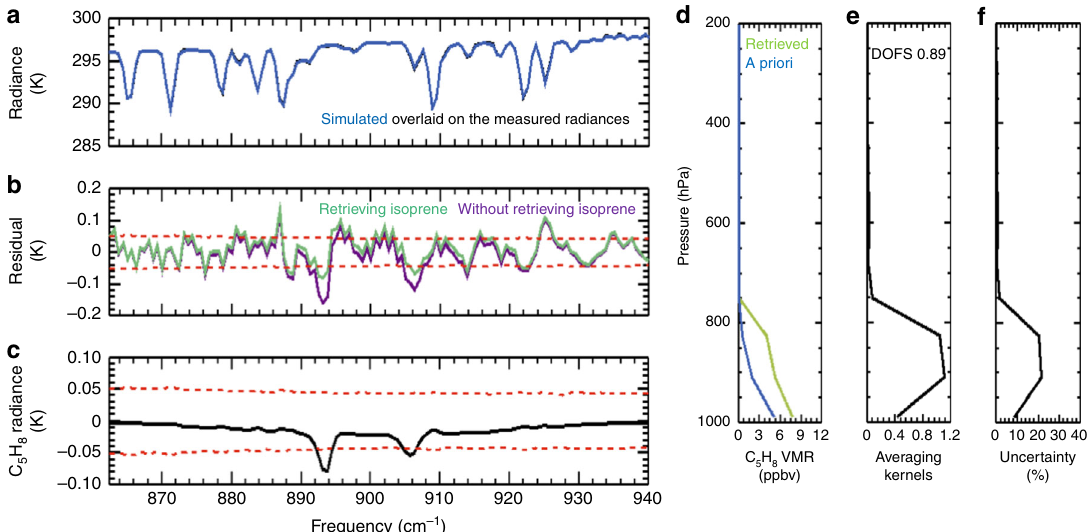
Fig. 4 An example CrIS isoprene retrieval over Amazonia (8.698°S, 69.134°W) on September 30, 2014. a Calculated (blue) spectrum overlaid on the CrIS- measured (black) spectrum, plotted in brightness temperature units. The major features are due to H 2 O vapor. b Residual spectra (observed — calculated) after accounting for water vapor (H 2 O), nitric acid (HNO 3 ), ammonia (NH 3 ), and relevant surface and cloud properties. The purple line indicates the residual spectrum before accounting for isoprene (C 5 H 8 ), clearly showing the isoprene signals peaking at 893.75 cm − 1 ( ν 28 band) and 906.25 cm − 1 ( ν 27 band). The green line depicts the residuals after fi tting for isoprene. The red dashed lines denote the single-pixel CrIS noise level as reported in the CrIS L1B data product. c Difference between the residual spectra when including vs. excluding atmospheric isoprene in the fi tting — illustrating the isoprene spectral signal in this example. d A priori (blue) and retrieved (green) isoprene volume mixing ratios (VMR). e Sum of the rows of the averaging kernel matrix for the isoprene retrieval, showing 0.9 degrees of freedom for signal (DOFS) in this example. f Estimated uncertainty of the